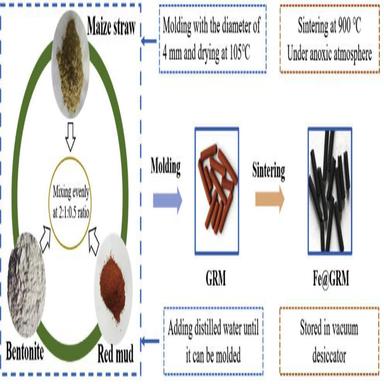
Scheme diagram for the Fe@GRM preparation.